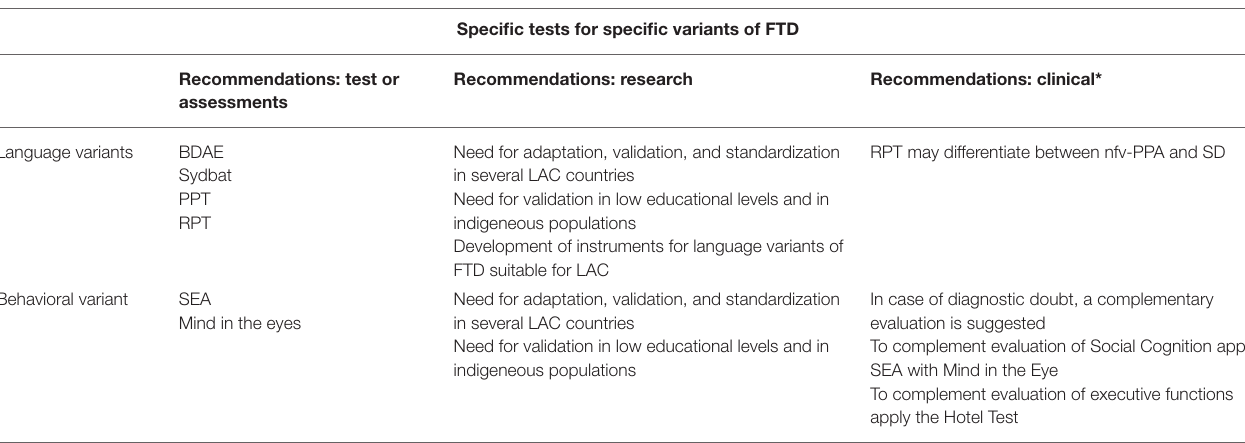
TABLE 2 | Specific tests for specific variants of